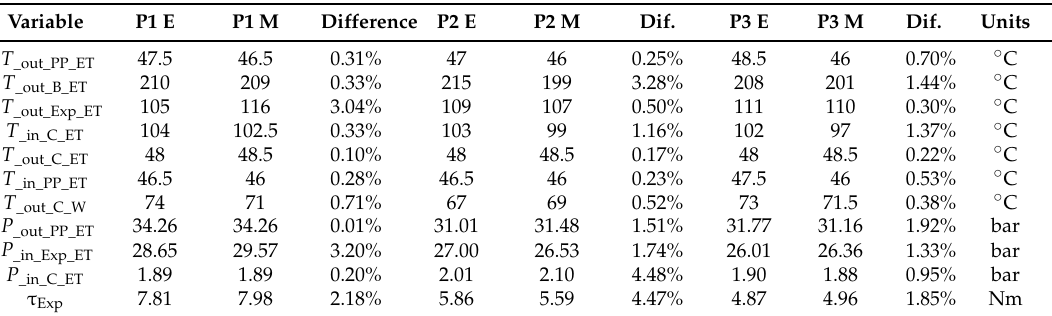
Table 7. Outputs of the ORC model.